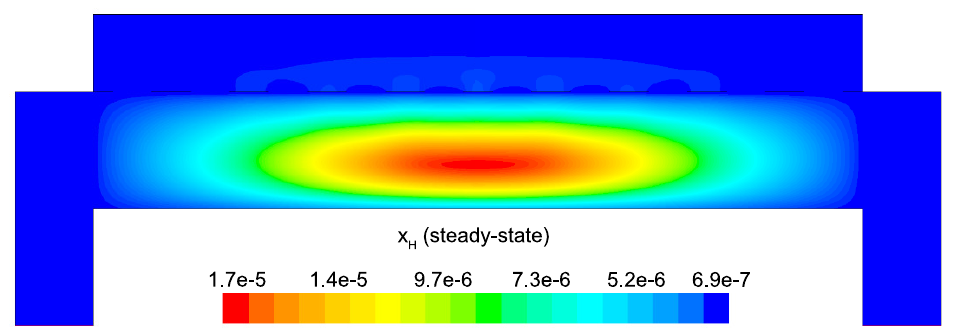
at T = 475 K and P = 1 Torr. 3